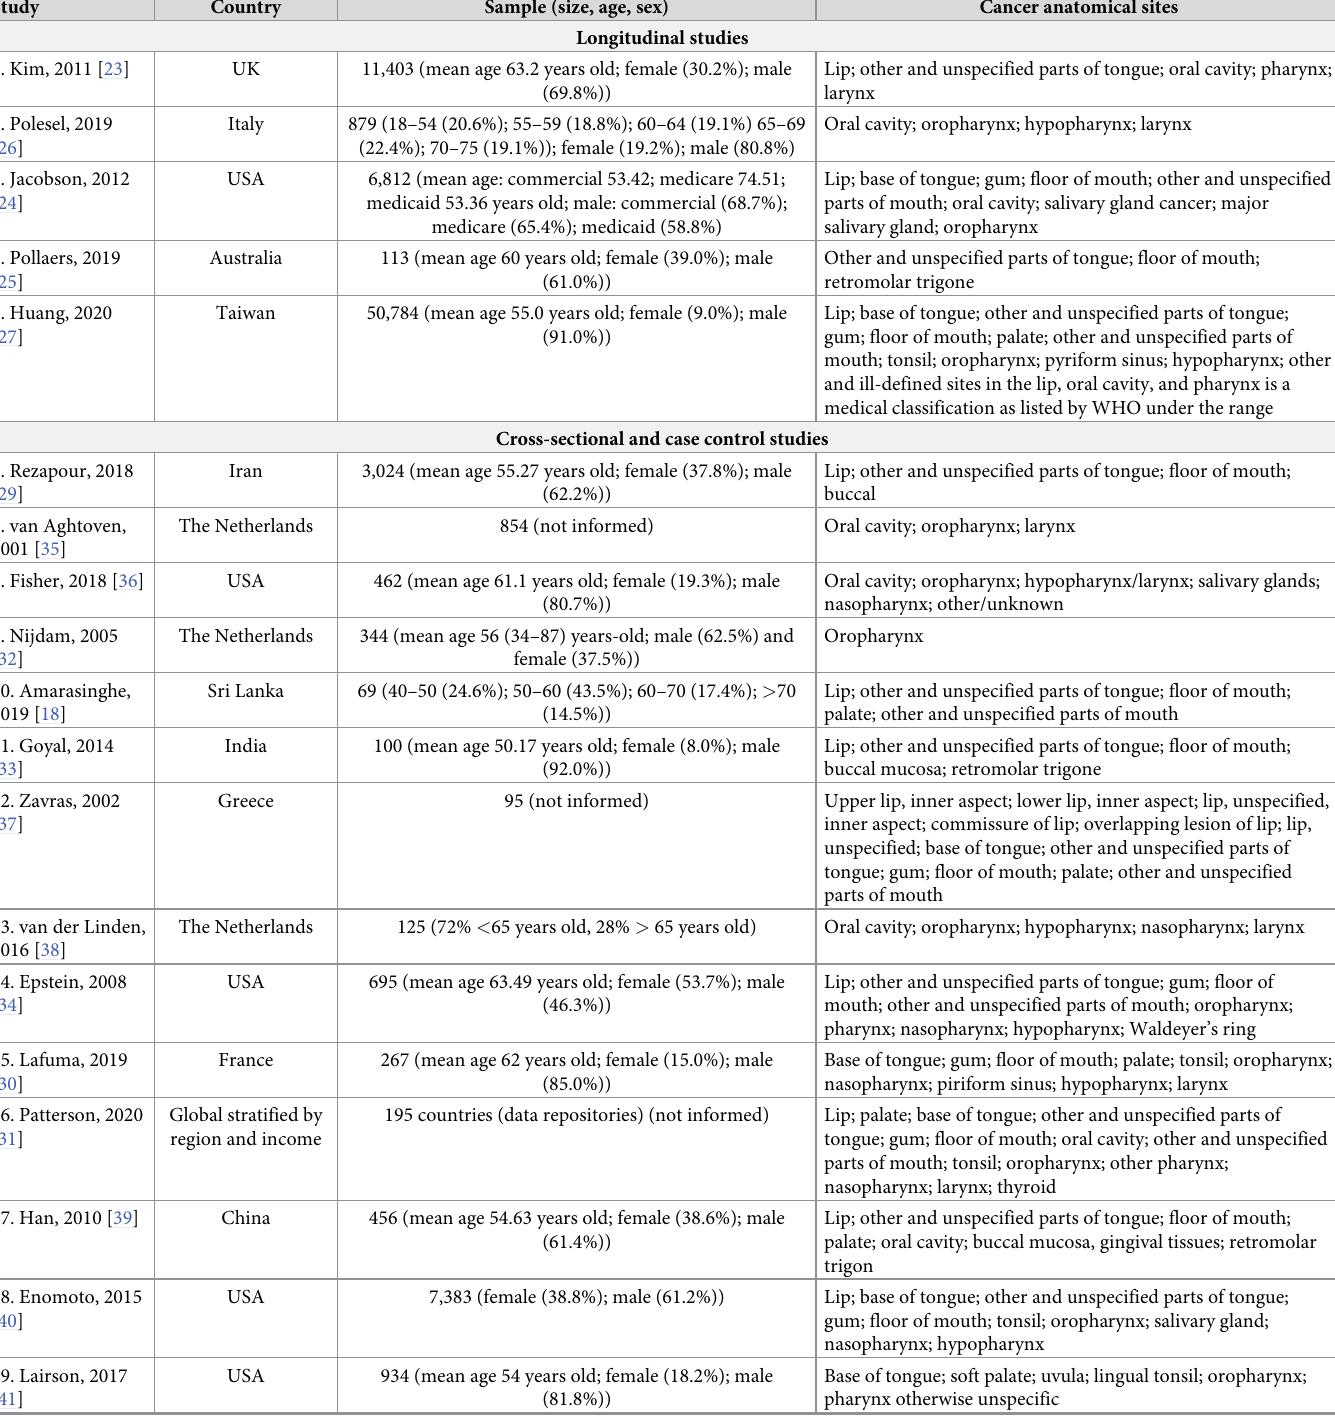
Table 1. Summary of main characteristics of oral cancer cost studies from 2001 to 2020 (n =